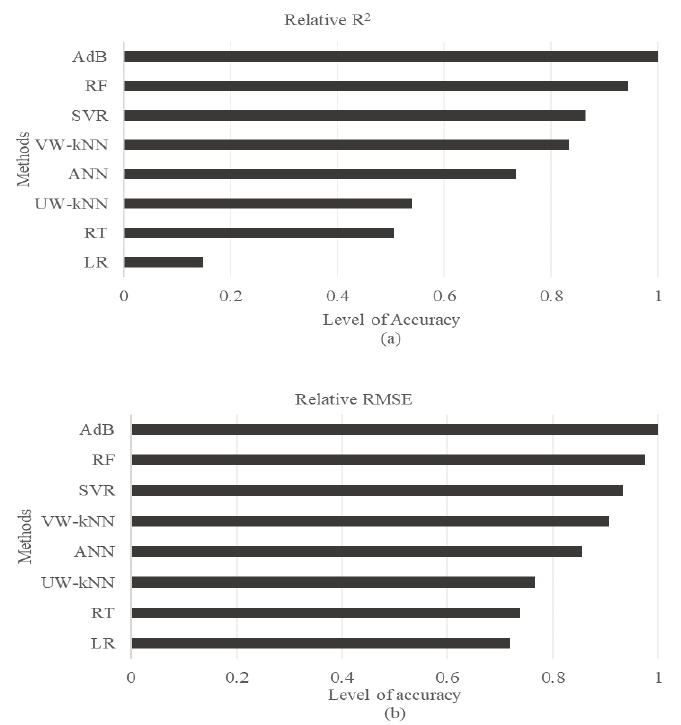
Figure 10. Relative comparison between ( a ) the coefficient of determination (R 2 ) values ( b ) the Root Mean Square Error (RMSE) values in the prediction